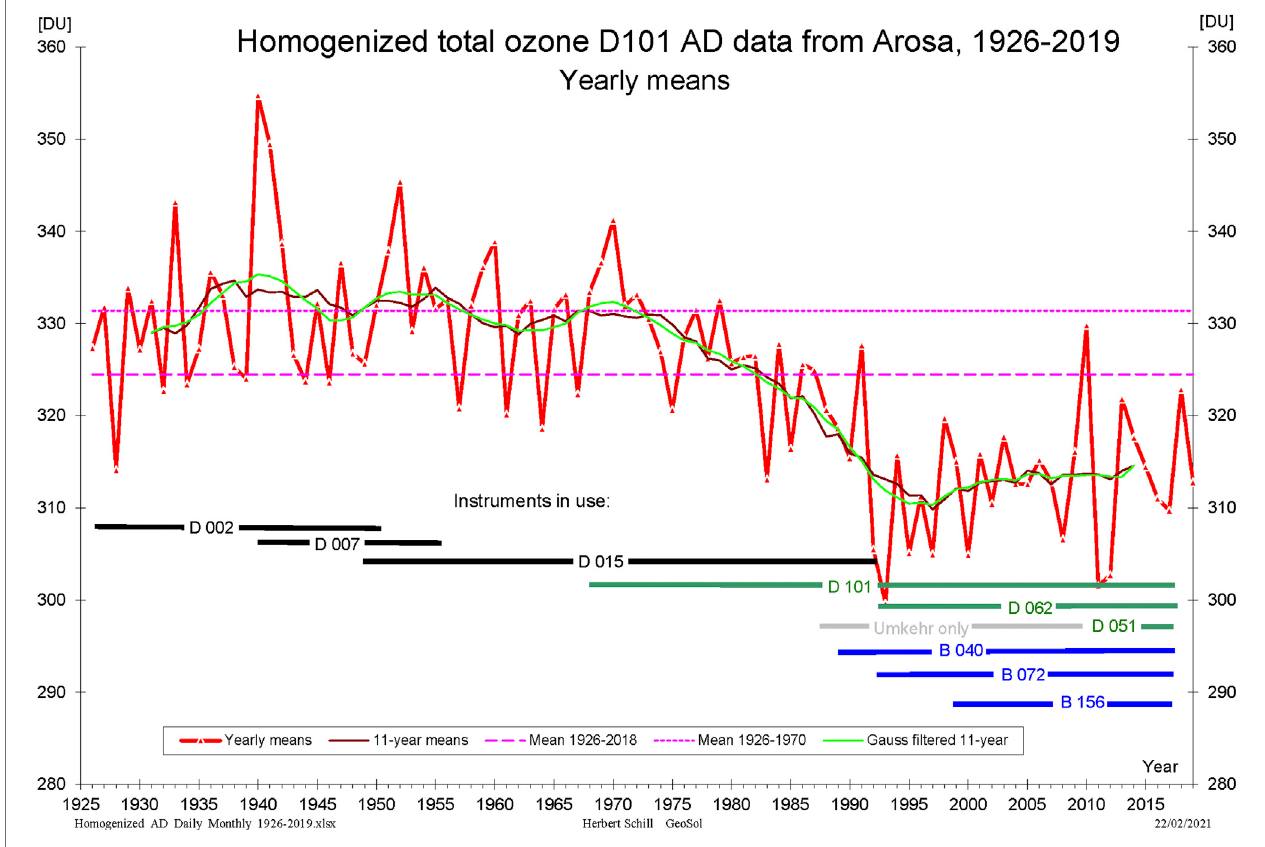
FIGURE 1 | Homogenized total column ozone from Arosa, 1926 to 2019. The four Dobson spectroradiometers D002, D007, D015, and D101 have been used to produce this time series for the measurement period.